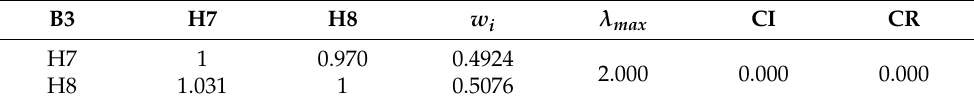
Table 9. Perceived cost judgment matrix and weight values.